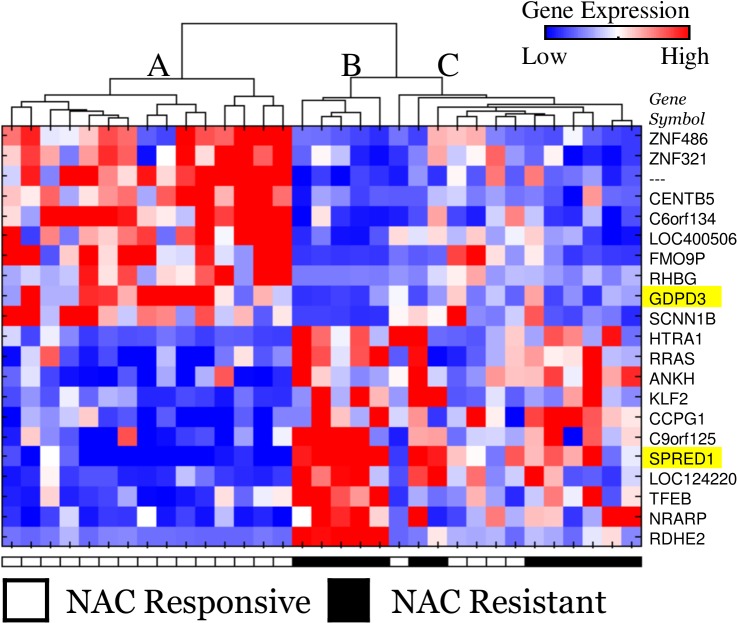
Gene expression patterns of response and resistance to NAC in MIBC.The heatmap and hierarchical dendrogram of the samples (rows—mRNA, columns—samples) using the 21 target mRNA species identified from the Kato et al. cohort shows robust differences that correlate well to NAC response status. Unsupervised clustering revealed three distinct yet related sample groups designated as A, B, and C in the dendrogram. The two genes selected in the IHC based prediction model are highlighted in yellow.